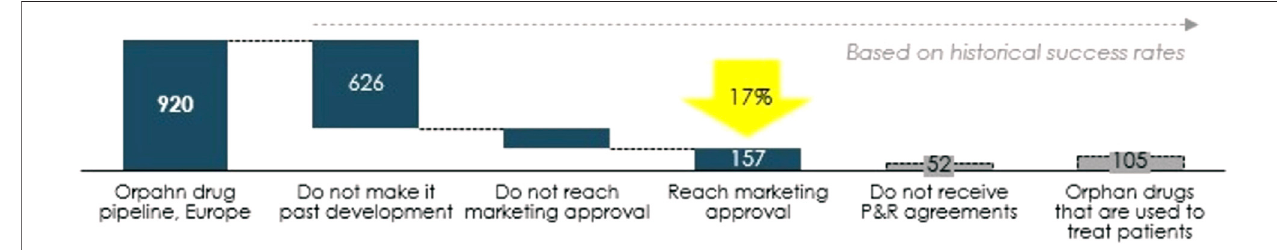
FIGURE 9 | From pipeline to orphan drugs accessible to patients, number of OMPs. Source: Copenhagen Economics based on EMA data (European Medicines Agency